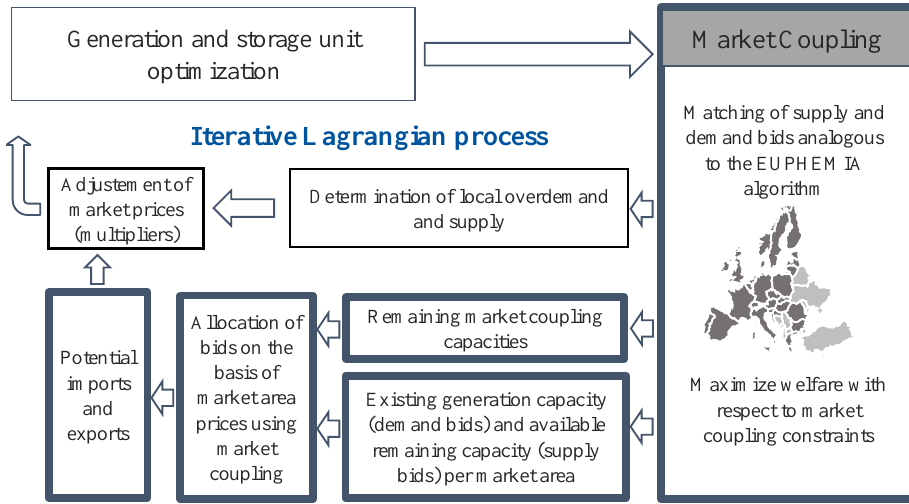
Figure 6. Iterative Lagrangian adjustment process.